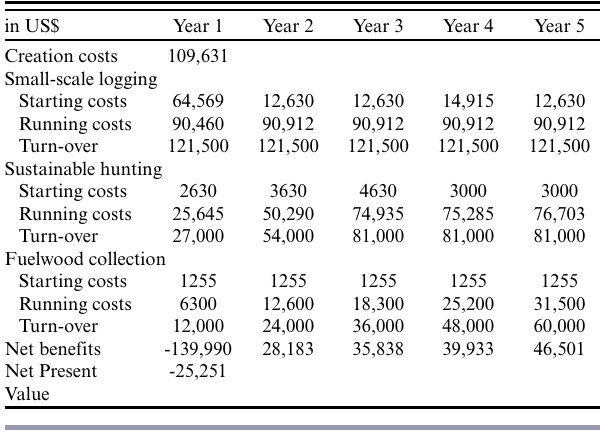
Table 2 . Financial cost-benefit analysis for the Lolwa local community forest concession.